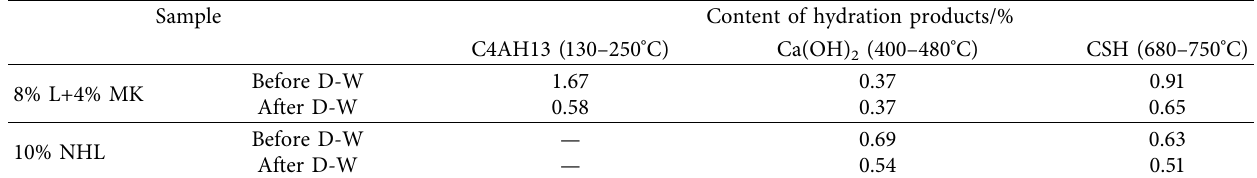
2, and C 4 AH 13 contents.